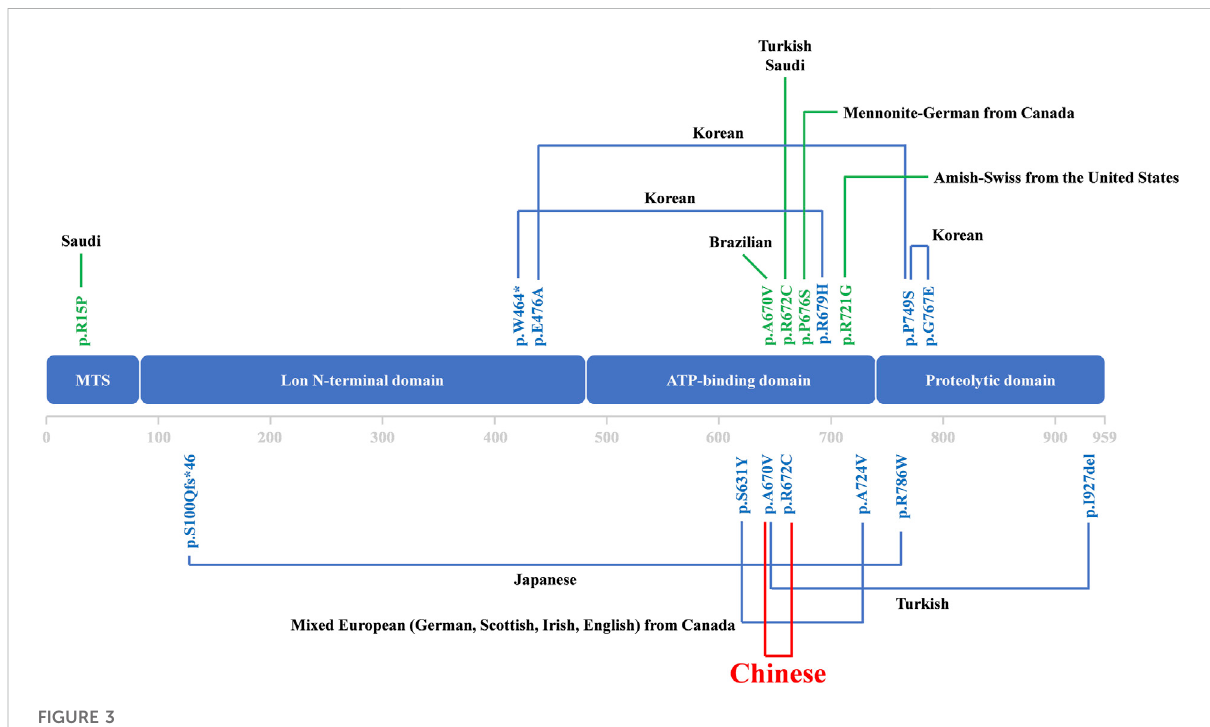
FIGURE 3 Overview of all reported CODAS syndrome cases caused by LONP1